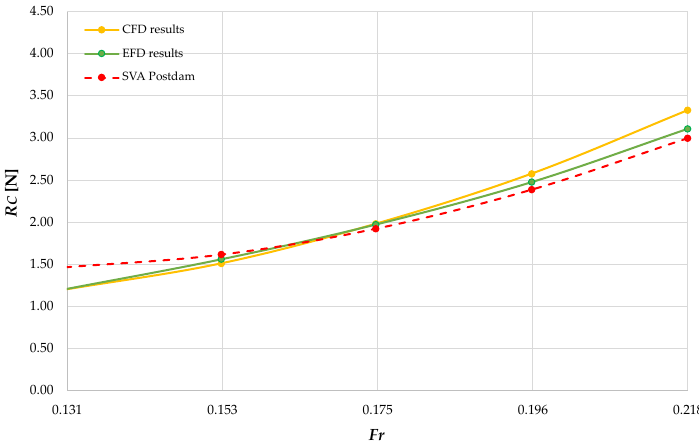
Figure 4. Resistance test.